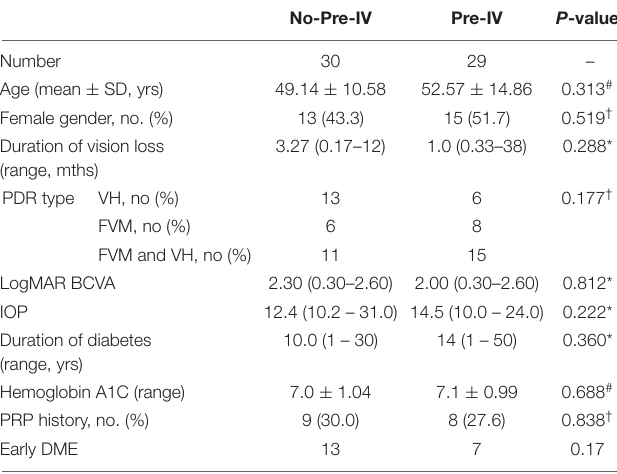
TABLE 1 | Baseline characteristics of included patients with